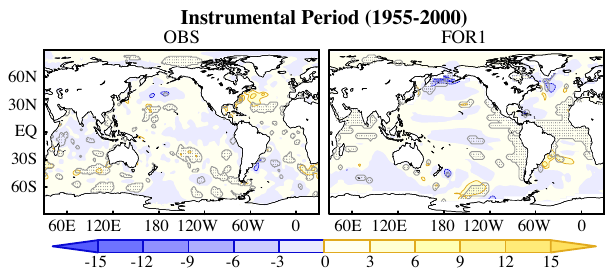
Fig. 6. Regression patterns between the OHC700 anomalies (in 10 8 Jm − 2 ) and the standardised total radiative forcing in Fig. 2 during the period 1955–2000 of the observations and the extended FOR1 run. Dotted areas enclose values exceeding the 95% confi- dence level according to a Student’s t test that takes into account the series autocorrelation to correct the sample